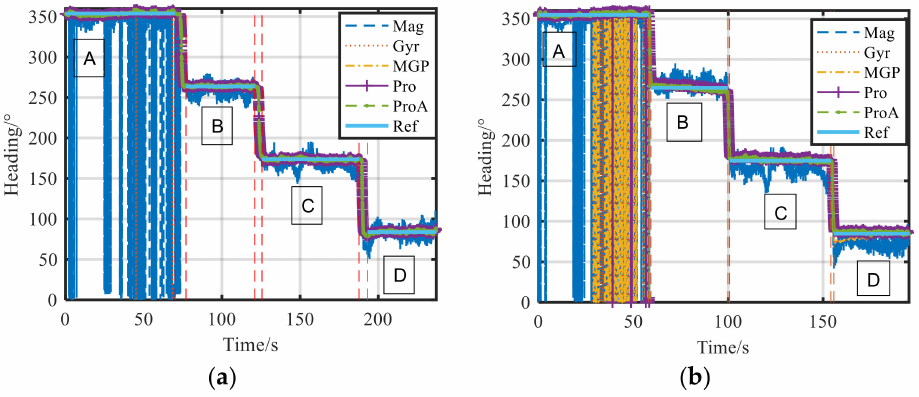
Figure 4. Heading estimation with di ff erent methods for di ff erent smartphones: ( a ) Heading of HV9; ( b ) Heading of